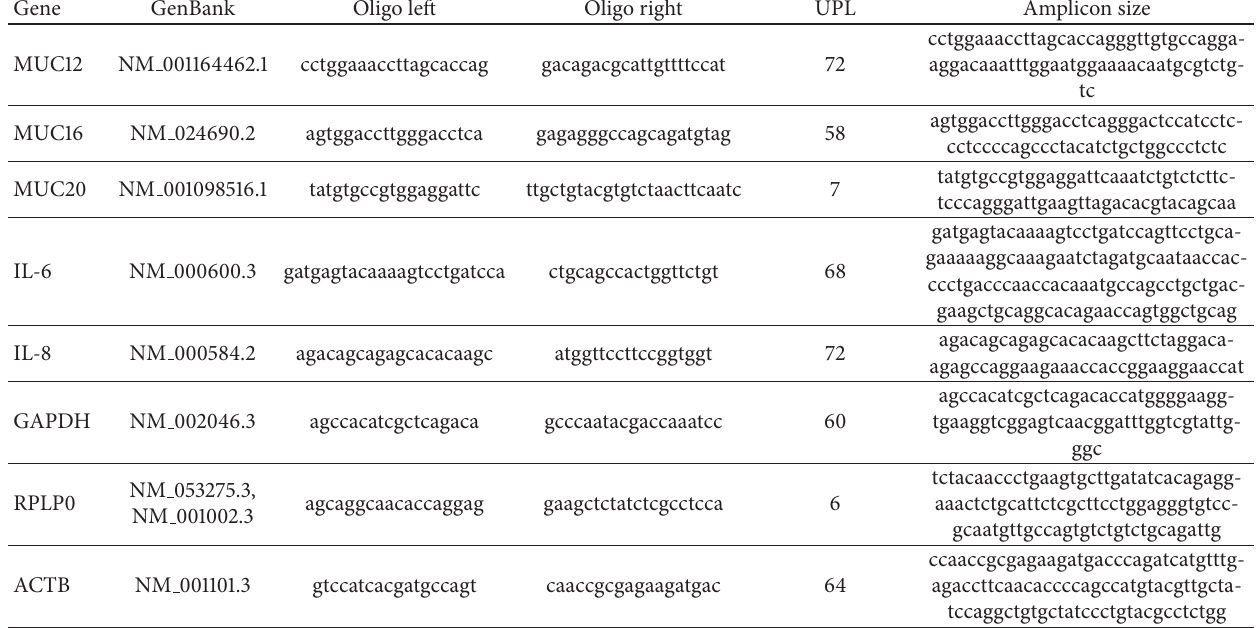
Table 1: Primers designs from Universal